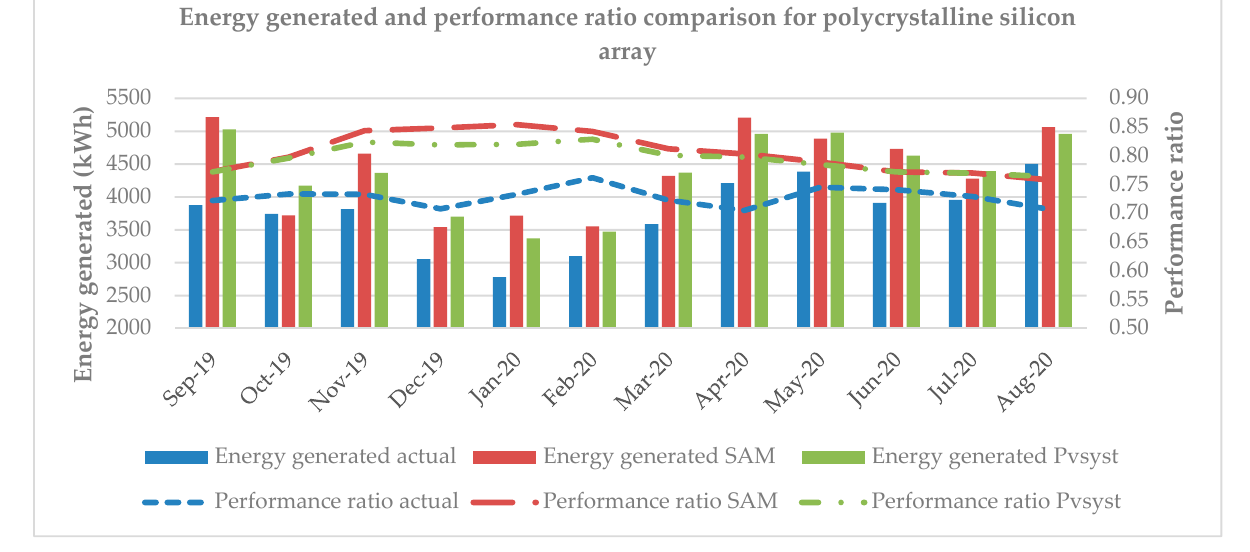
Figure 15. Comparison of actual energy generated and performance ratio to simulated values for polycrystalline silicon array.